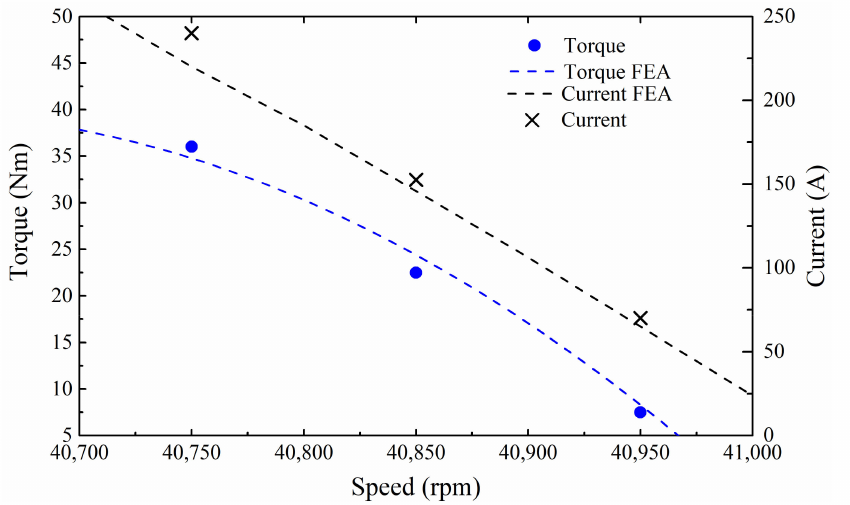
Figure 16. Comparison of performances at high